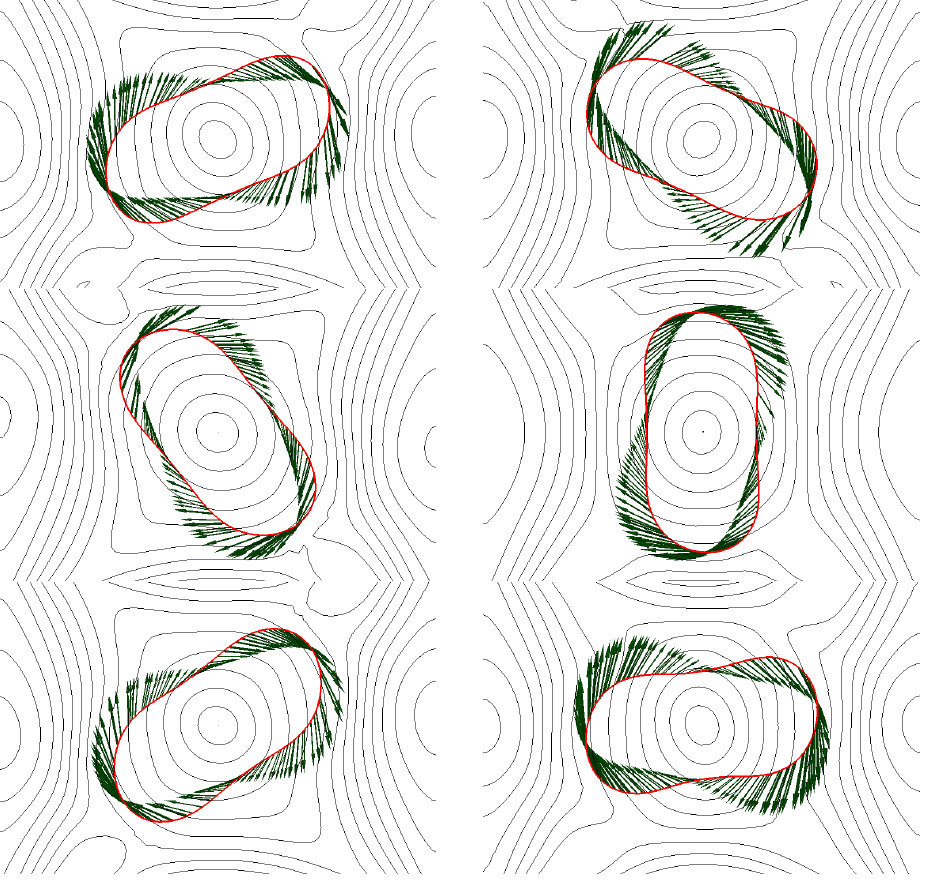
Figure 7. Flowing vesicle with v = 0.77 following a TB regime for ¯ µ = 10, Re = 10 − 3 and Bn = 10 3 at times t 2.27,2.70,2.88,3.09,3.25,3.62 . The membrane is plotted in red, while the tangential ∈ { } velocity is plotted in green. [Colour figure can be viewed